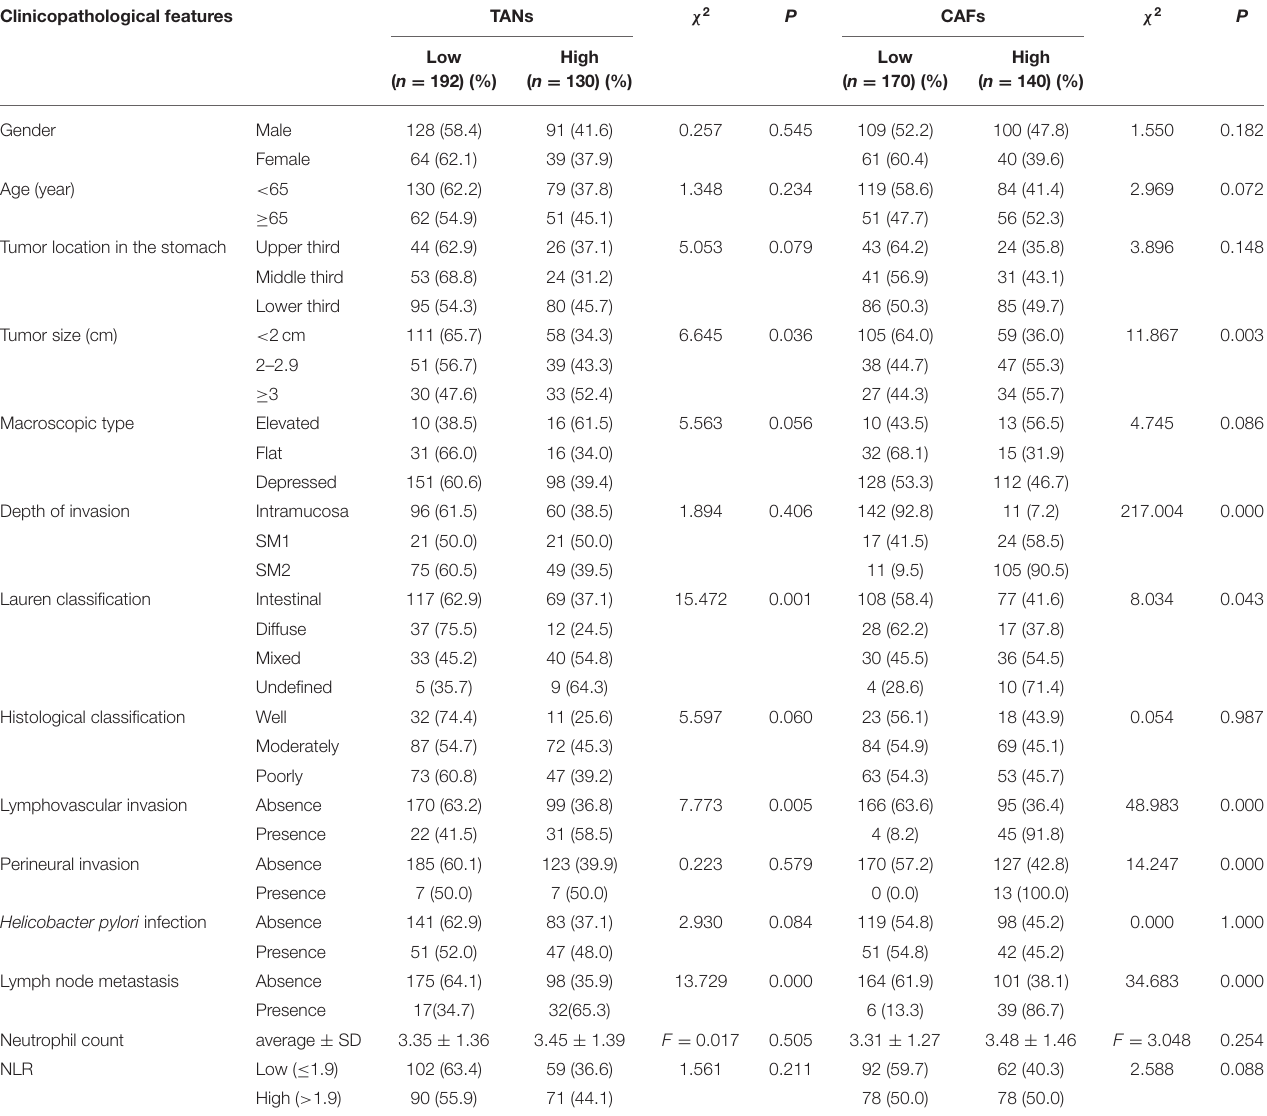
TABLE 1 | The clinical significance of TANs and CAFs in the EGC tissues. Clinicopathological